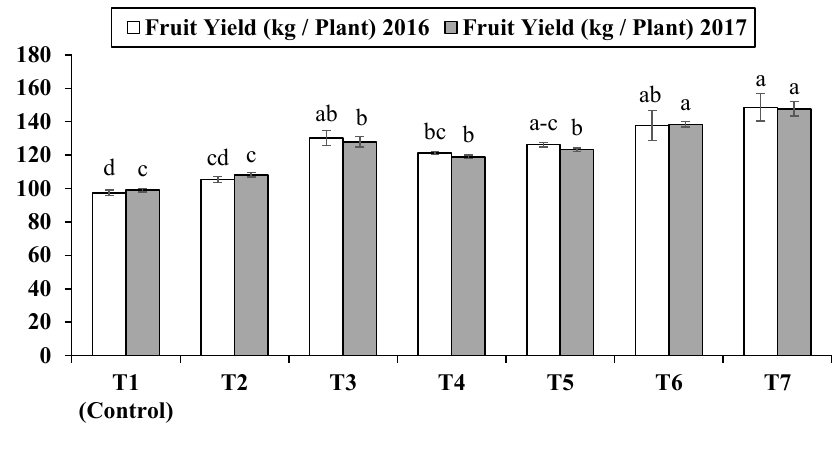
Figure 4. Effects of foliar application of variable sources of Ca and K with B on SB Chaunsa fruit yield /